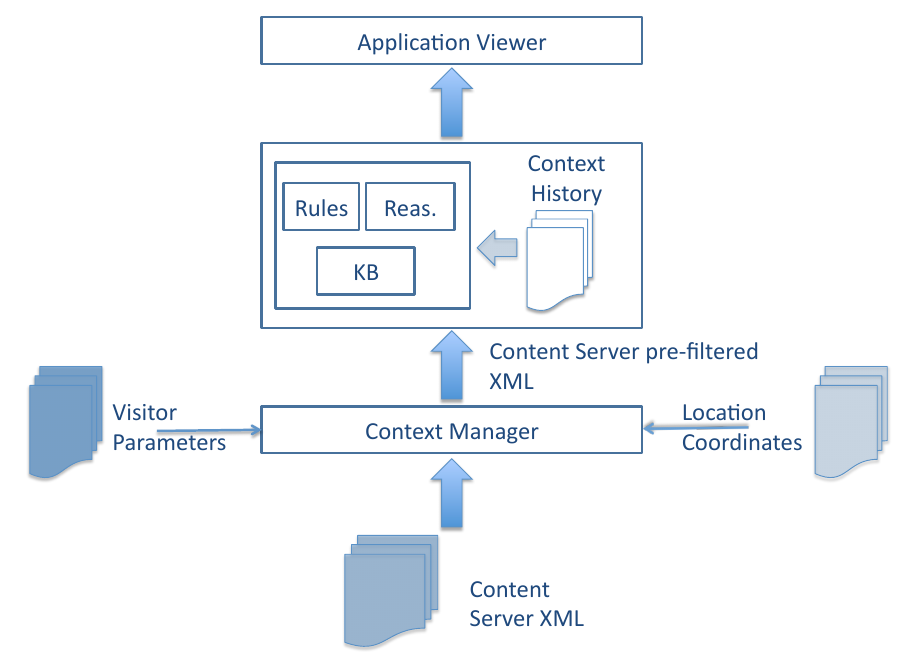
Figure 4. Architecture of Contextual Computing in